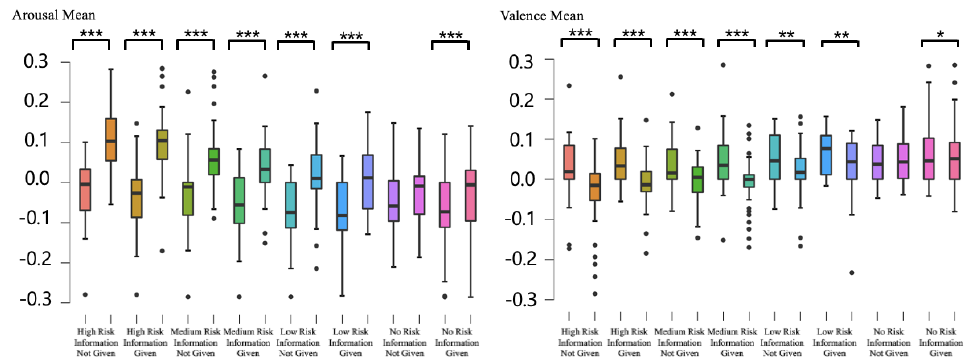
Figure 8. A graph comparing Arousal mean and Valence mean data before and after the event. The use of asterisks in the figure indicates statistical significance. A single asterisk (*) denotes a p -value less than 0.05, while two (**) and three (***) asterisks denote p -values less than 0.01 and 0.001,